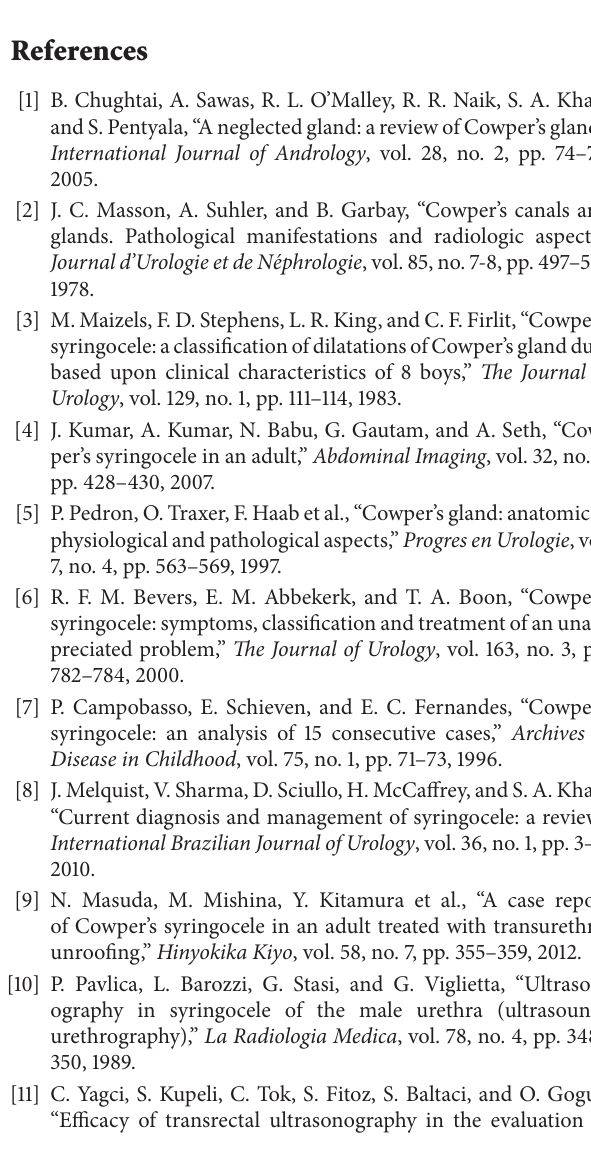
Figure 3: (a) Urethroscopy following transurethral unroofing between the syringocele and the bulbar urethra. (b) Retrograde urethrogram showing a widened bulbar urethra following unroofing of syringocele